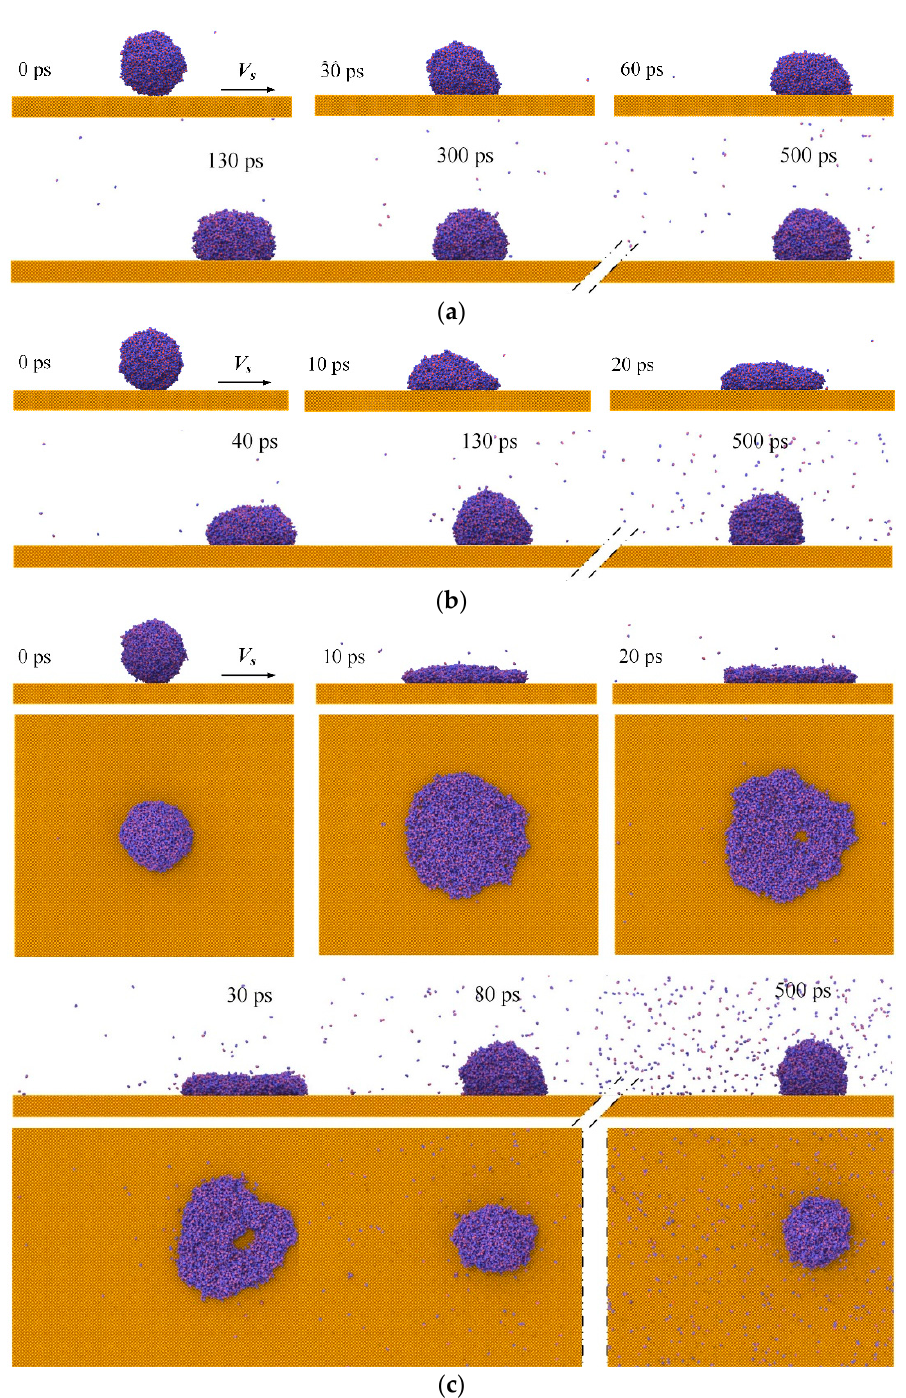
Figure 9. Morphological evolution of water nanodroplets with various We impinging on the translation surfaces: ( a ) We = 0.82; ( b ) We = 20.58; ( c ) We = 66.67. The contact hysteresis can be seen for water nanodroplets with We = 0.82~20.58, as